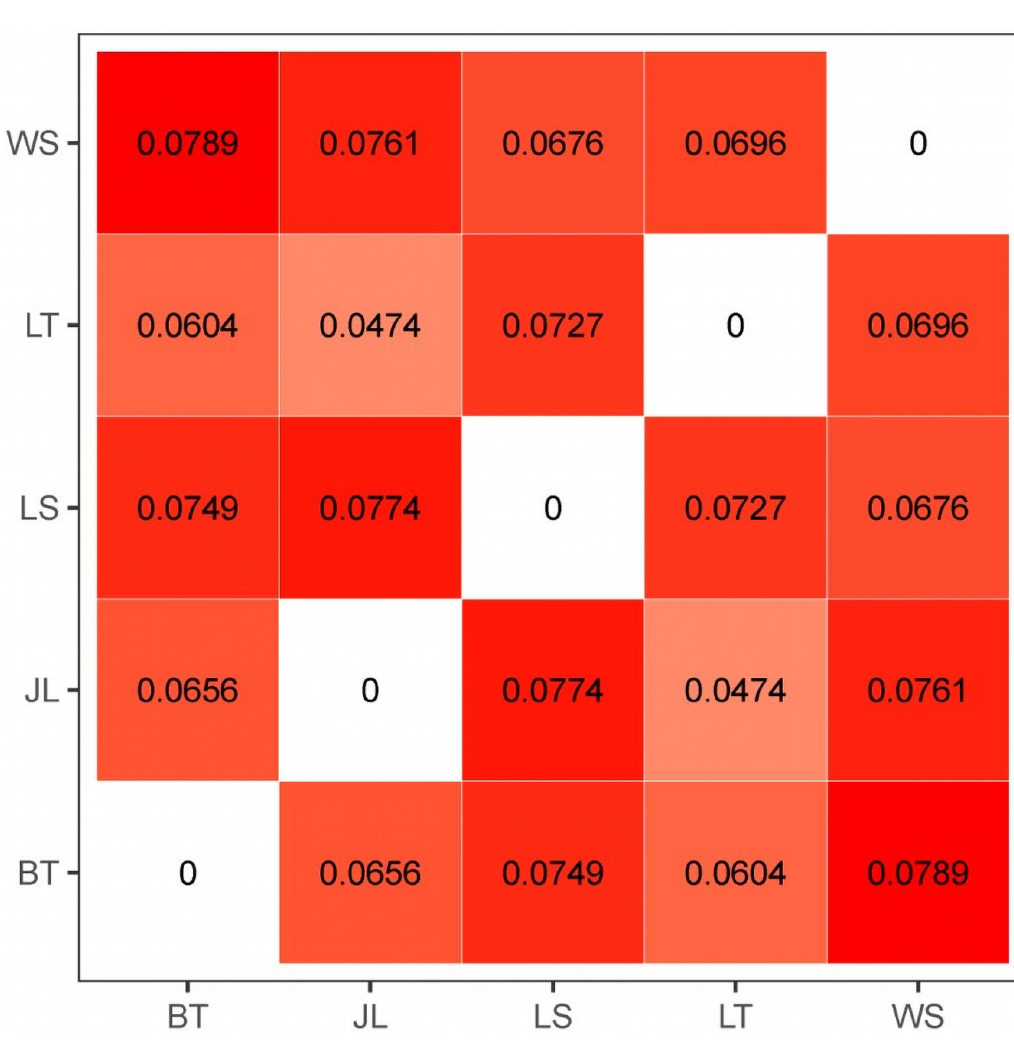
Fig 4. Pairwise wright’s F ST values among the five